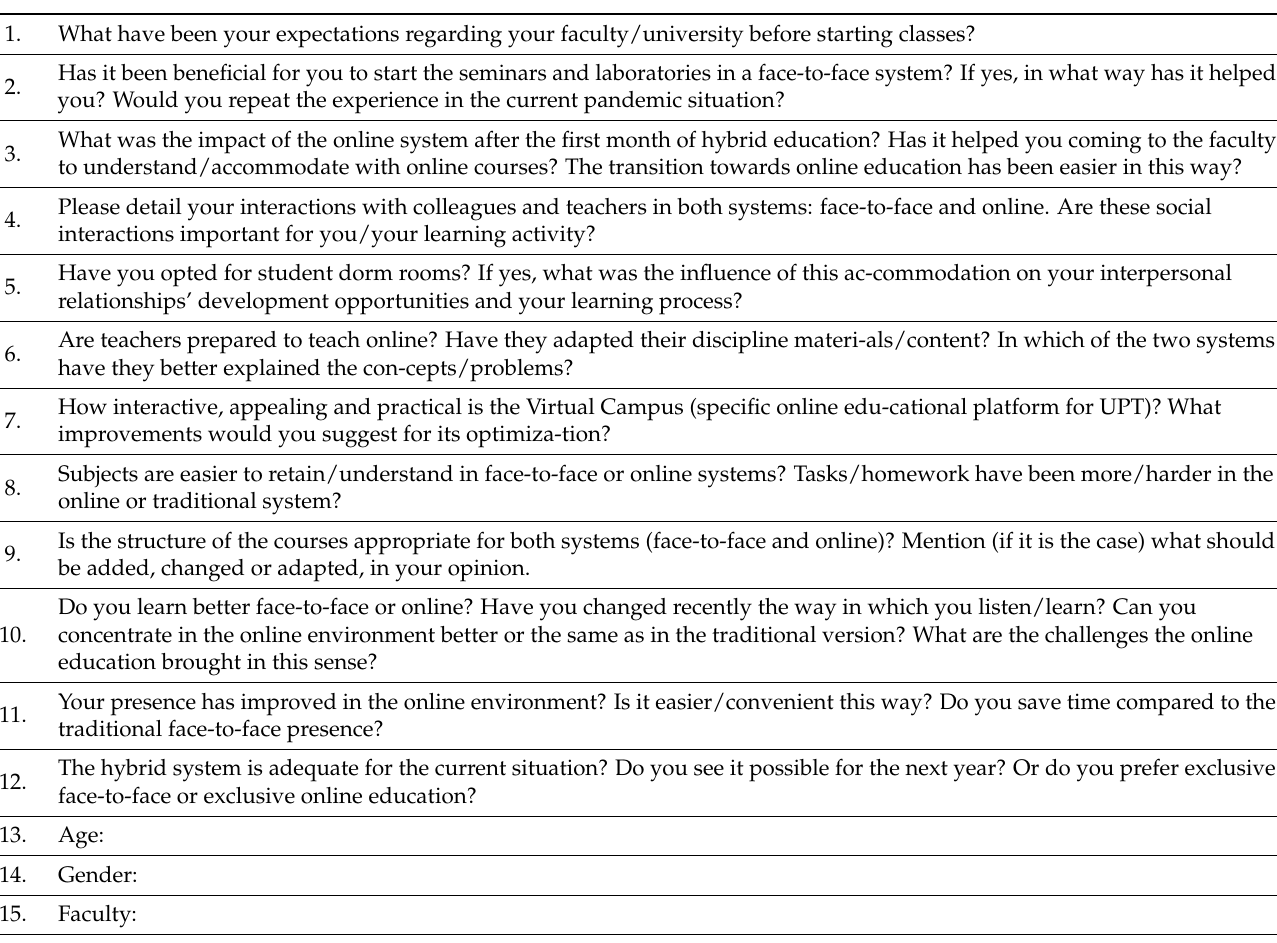
Table A1. In-depth interview for determining student’s satisfaction level regarding the hybrid education system in Politehnica University Timisoara—Interview